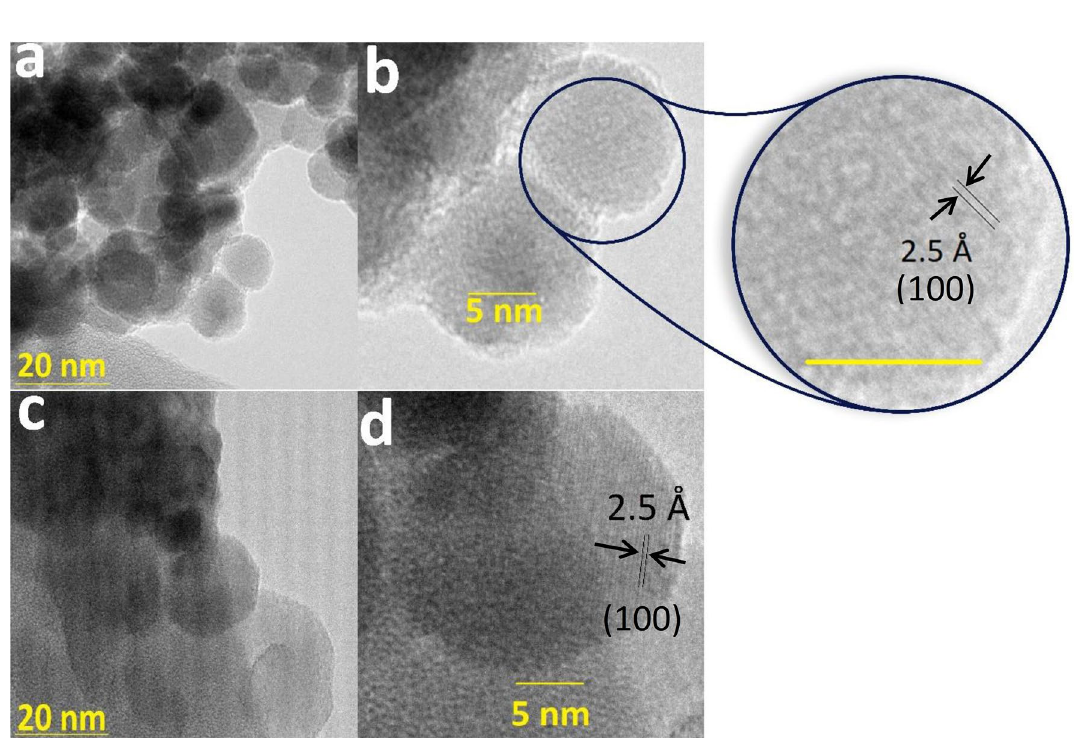
Figure 3. TEM images for 1 at different magnifications before ( a , b ) and after the methylphenyl sulfide oxidation ( c , d ). Scale bar for inset is 5.0